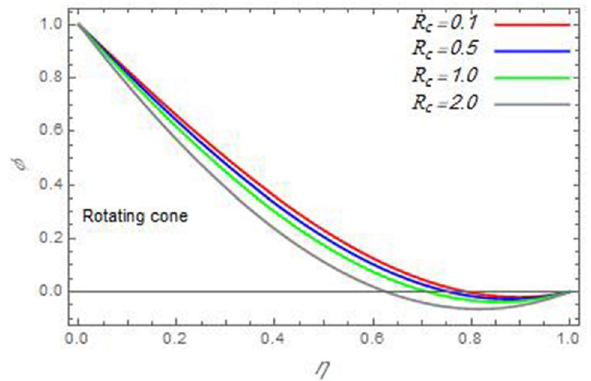
Figure 25. The nanoparticles volume fraction distribution ϕ is plotted versus the axial variable η in the case of stationary disc to depict the effect of the chemical reaction parameter R c